Question: State the chart type depicted above.
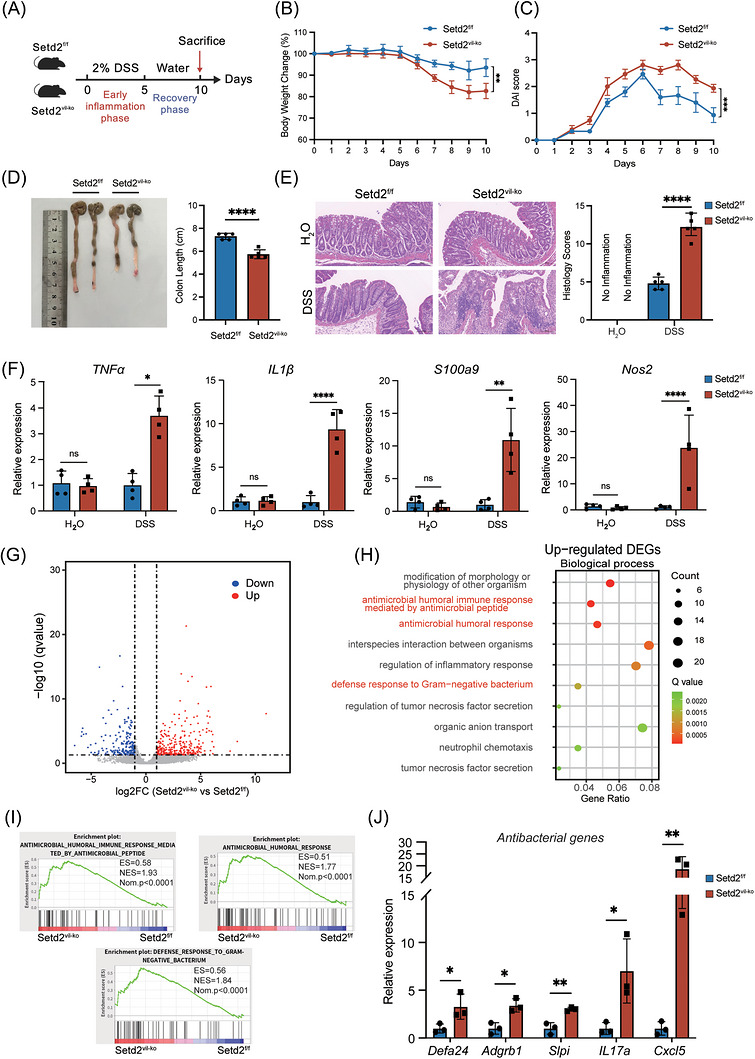
Answer: line